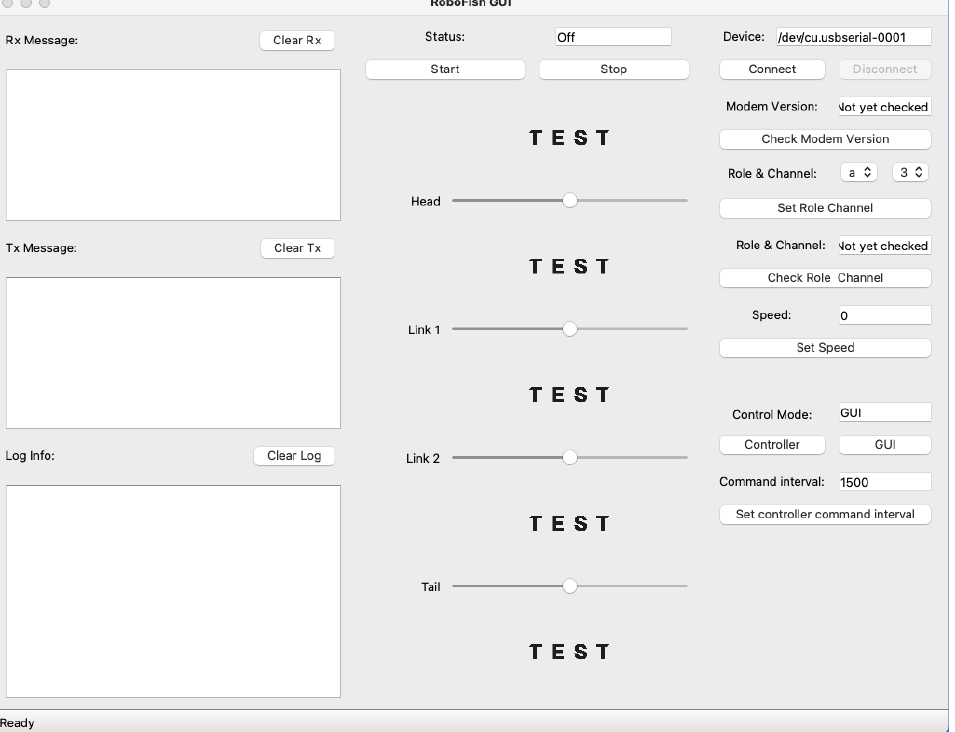
Figure 14. Python GUI for RoboFish Enabling Easier Interaction with the RoboFish Acoustic Modem based on its API: works as a messaging application to remotely change parameters and control RoboFish over an acoustic